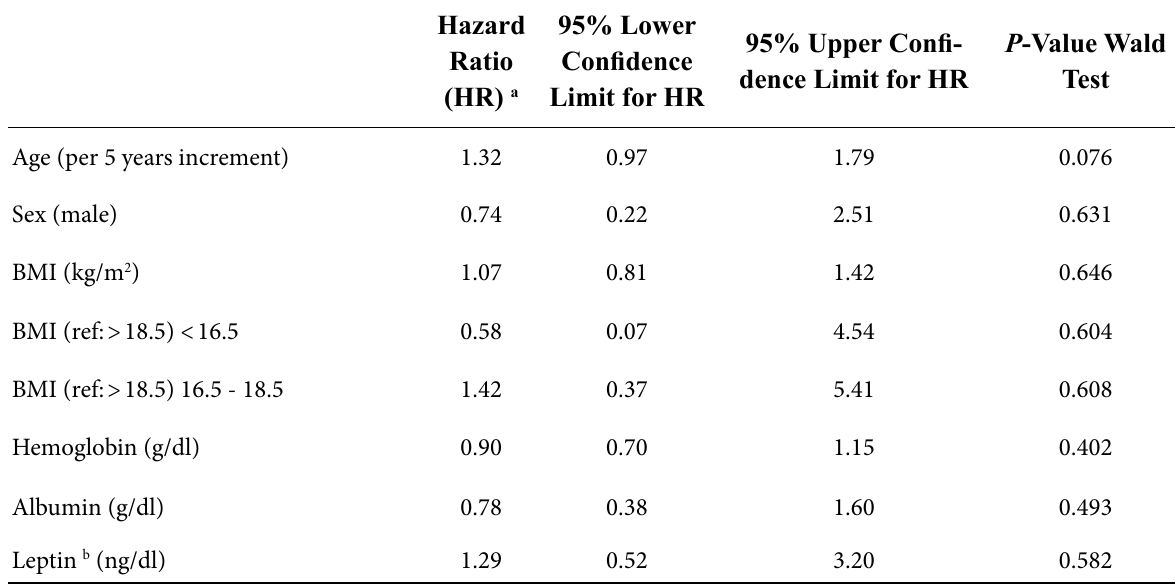
Table 2: Risk of Death Associated with Age, Sex, and Baseline Markers of Nutrition Hazard 95% Lower P -Value Wald 95% Upper Confi - Ratio Confidence dence Limit for HR Test (HR) a Limit for HR Age (per 5 years increment) 1.32 0.97 1.79 0.076 Sex (male) 0.74 0.22 2.51 0.631 BMI (kg/m 2 ) 1.07 0.81 1.42 0.646 0.58 0.07 4.54 0.604 1.42 0.37 5.41 0.608 Hemoglobin (g/dl) 0.90 0.70 1.15 0.402 Albumin (g/dl) 0.78 0.38 1.60 0.493 Leptin b (ng/dl) 1.29 0.52 3.20